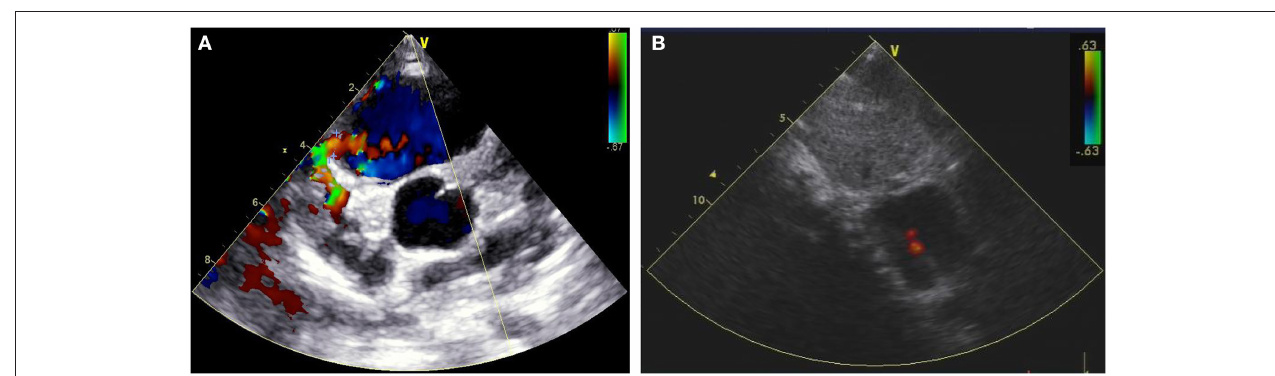
FIGURE 4 | Transthoracic echocardiography showing that a 6.28-mm coronary fistula into the right ventricle ( A , arrow) was detected preoperatively, and undetectable 1 week post-surgical ligation (B) .